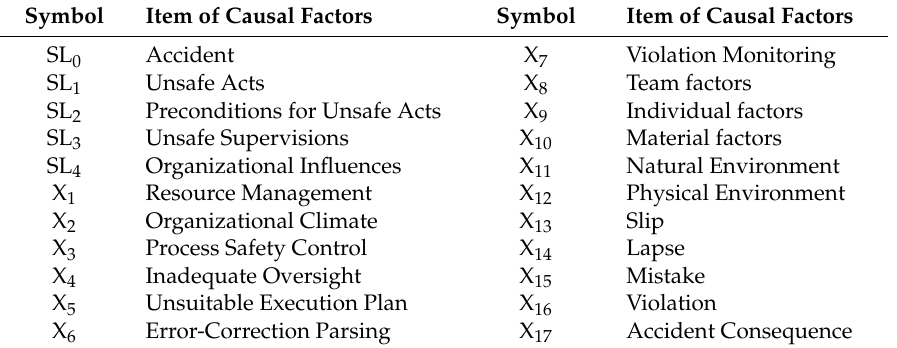
Table 1. Relationship of causal factors to marine